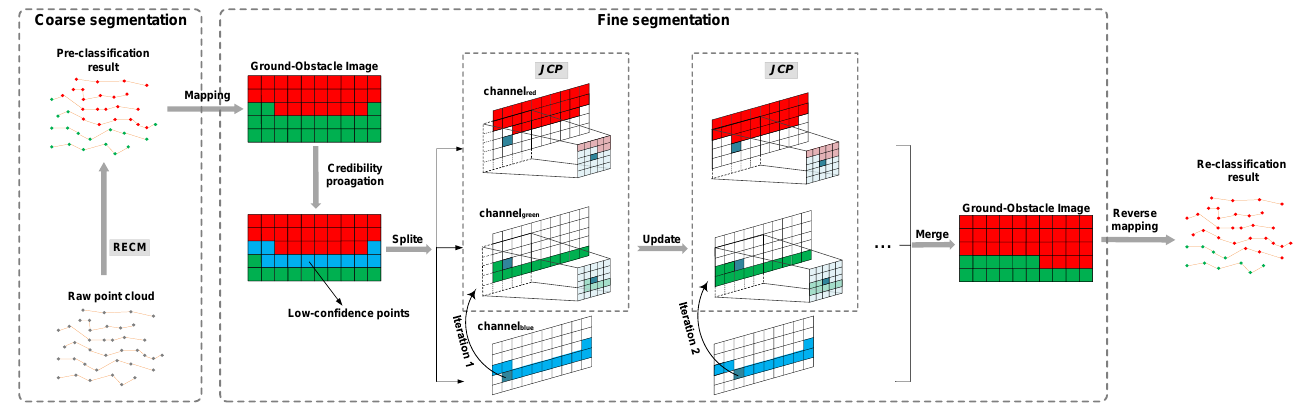
Figure 2. The framework of the proposed method. RECM and JCP are for ring-shaped elevation conjunction map and jump convolution process,